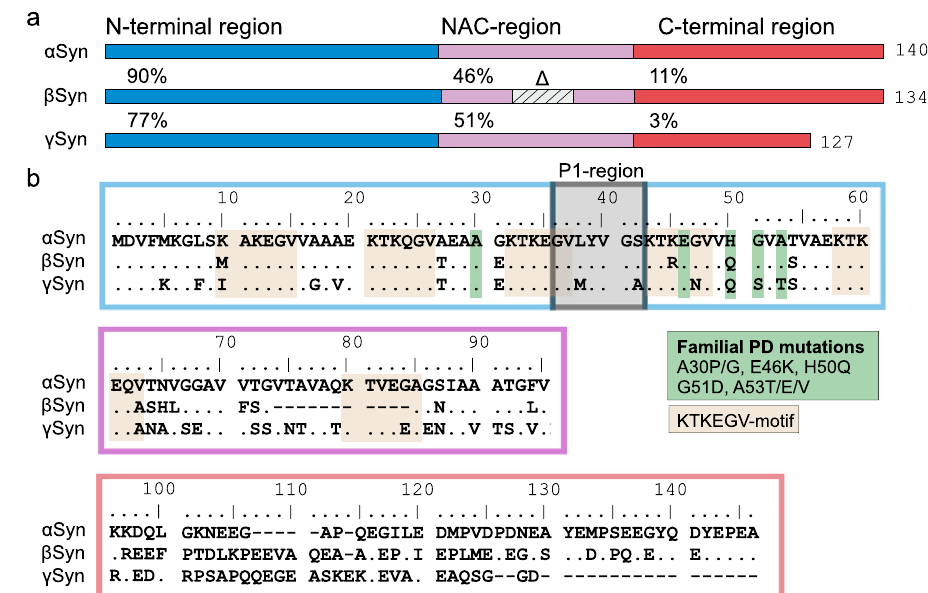
Fig. 1 | Sequence alignment of α -, β - and γ Syn. a Each protein comprises three regions:theamphipathicN-region(blue),theamyloidogenicNACregion(pink)and the acidic C-terminalregion (red).The sequenceidentity of β Syn and γ Synto α Syn foreachregionisshown.ThehatchedpinkregioninthecentreofNACfor β Syn( Δ ) depicts residues in the highly aggregation NAC core (residues 74 – 84) that are deleted in this sequence. The number of residues in each protein is shown on the